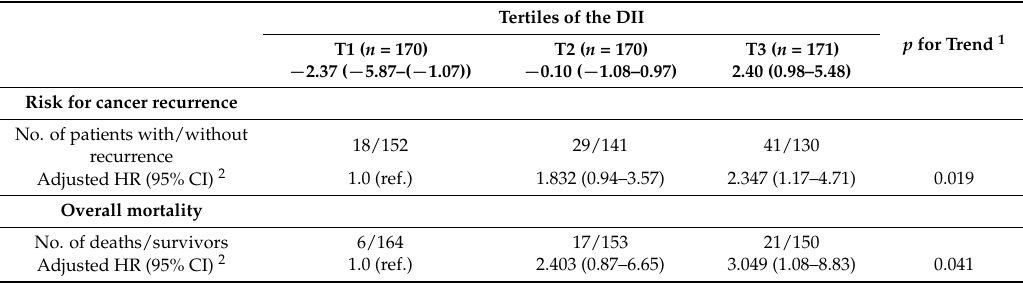
Table 2. Cox proportional hazards regression analysis of recurrence and mortality in patients with breast cancer according to the dietary inflammatory index